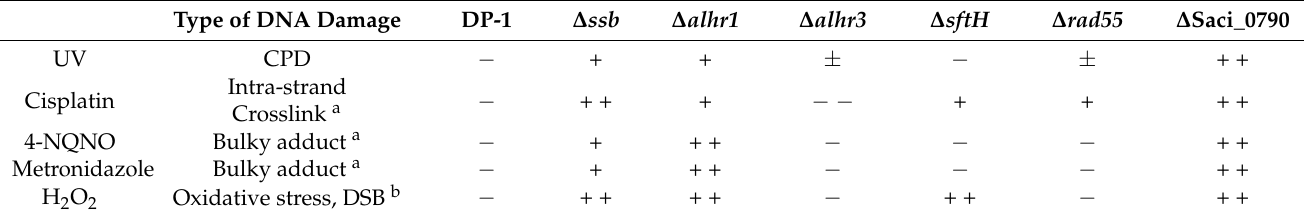
Table 1. Sensitivities of gene-deleted strains to DNA